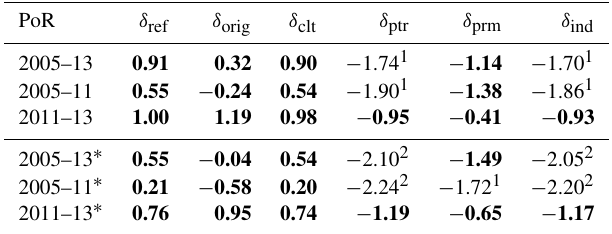
Table 4. Reduced discrepancies δ for all extrapolation methods used in this reanalysis and for the original mass balance record. The up- per panel shows results without the consideration of basal and inter- nal melt, while the lower panel ( ∗ ) refers to δ calculated accounting for subsurface melt. Bold values refer to agreement on the 90% confidence